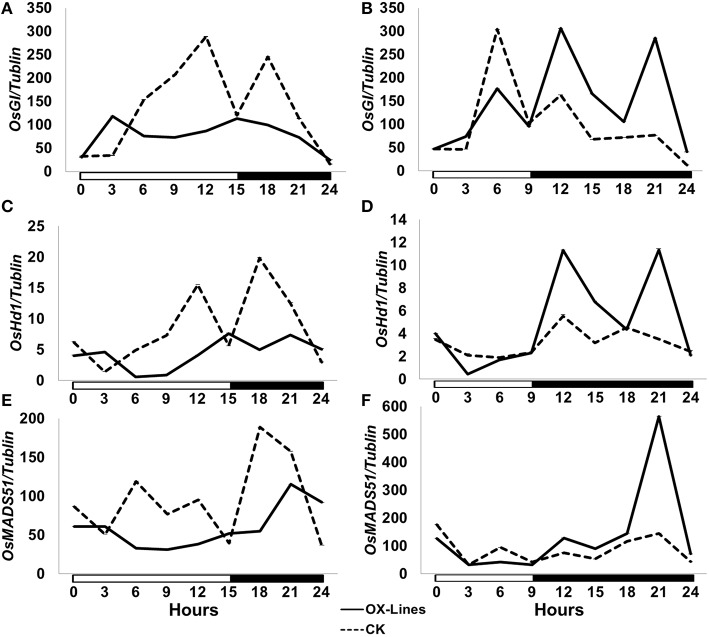
Expression of major photoperiod genes in truncated TaPRR73-OX rice lines and cv. Nipponpare check. (A,C,E) Expression levels of OsHd1, OsGI, and OsMADS51 under LDs (15 h light/ 9 h darkness). (B,D,F) The expression level of OsGI, OsHd1, and OsMADS51 under SDs (9 h light/ 15 h darkness). Four biologically independent replications were performed for each sample. White boxes below the graphs indicate light periods; dark boxes indicate darkness. The data were normalized by tubulin.